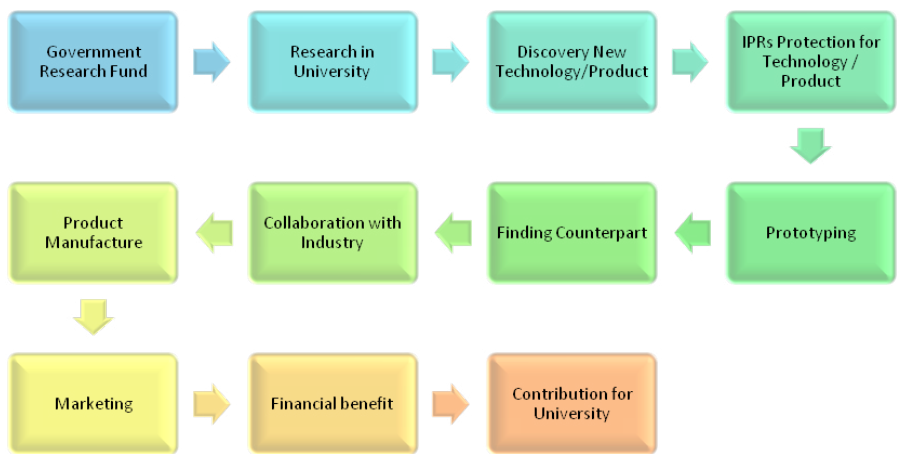
Figure 1. University Technology Transfer Road